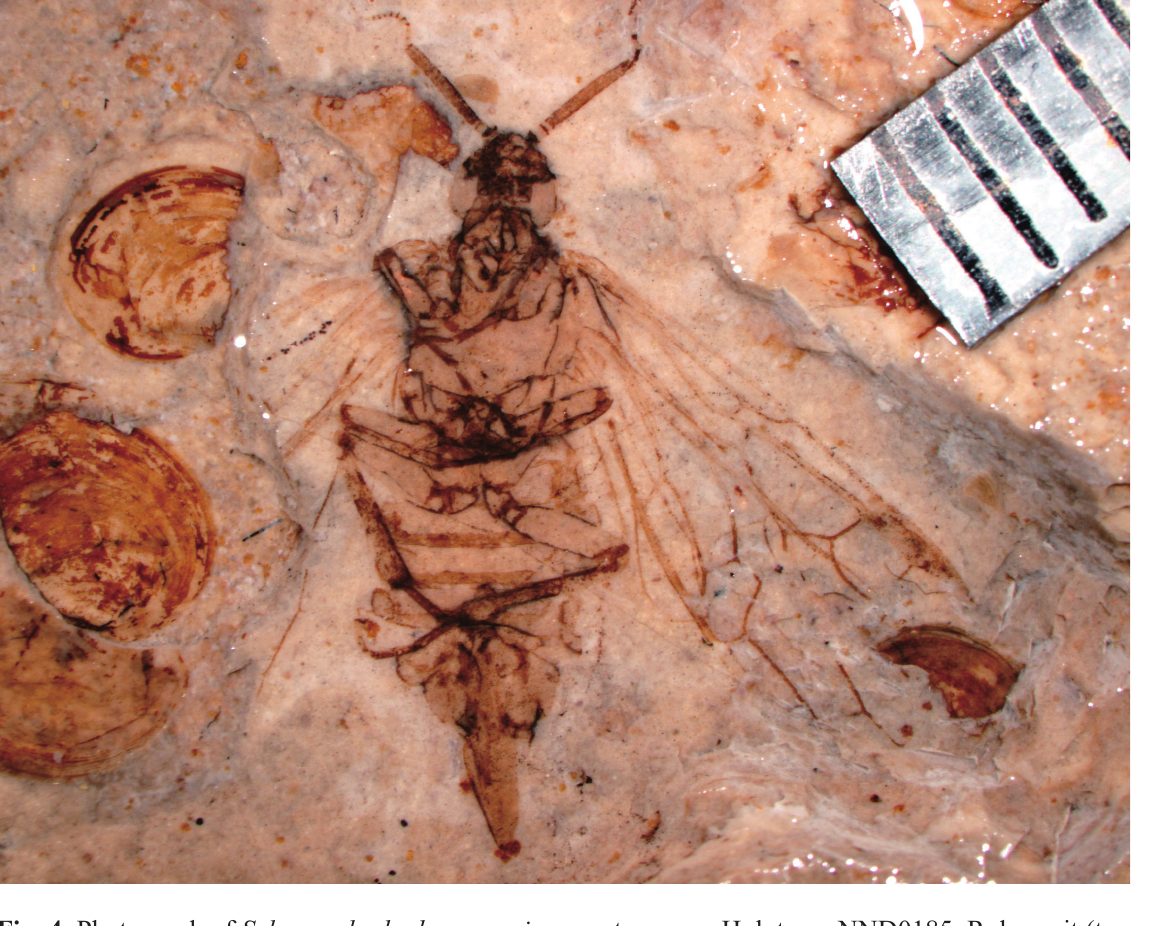
Fig. 4. Photograph of Scleroxyela daohugouensis gen. et sp. nov. Holotype, NND0185. Ruler unit (top right): 1